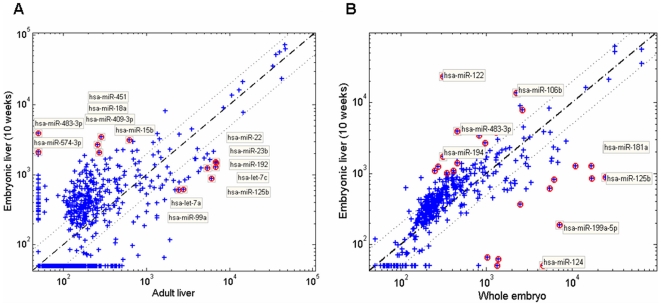
miRNA expression in embryonic liver vs. adult liver and vs. embryo without liver.Scatter plots representing miRNA expression profiles of 507 known miRNAs and additional predicted miRNAs of Rosetta Genomics in samples of embryonic liver (10 weeks) vs. adult liver (A) or vs. the corresponding embryo without liver sample (B). Each blue cross represents a miRNA, and the top 15% of the upregulated and downregulated miRNAs are labeled with red circles. Names of outlier miRNAs are indicated.